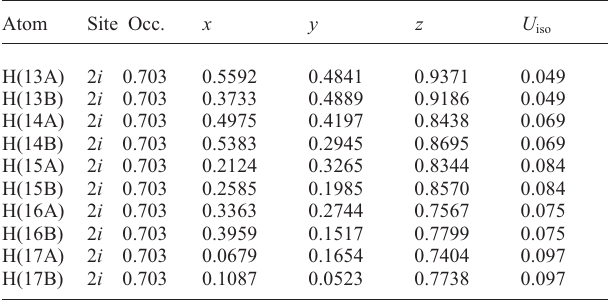
Table 2. Atomic coordinates and displacement parameters (in Å 2 ) . Atom Site